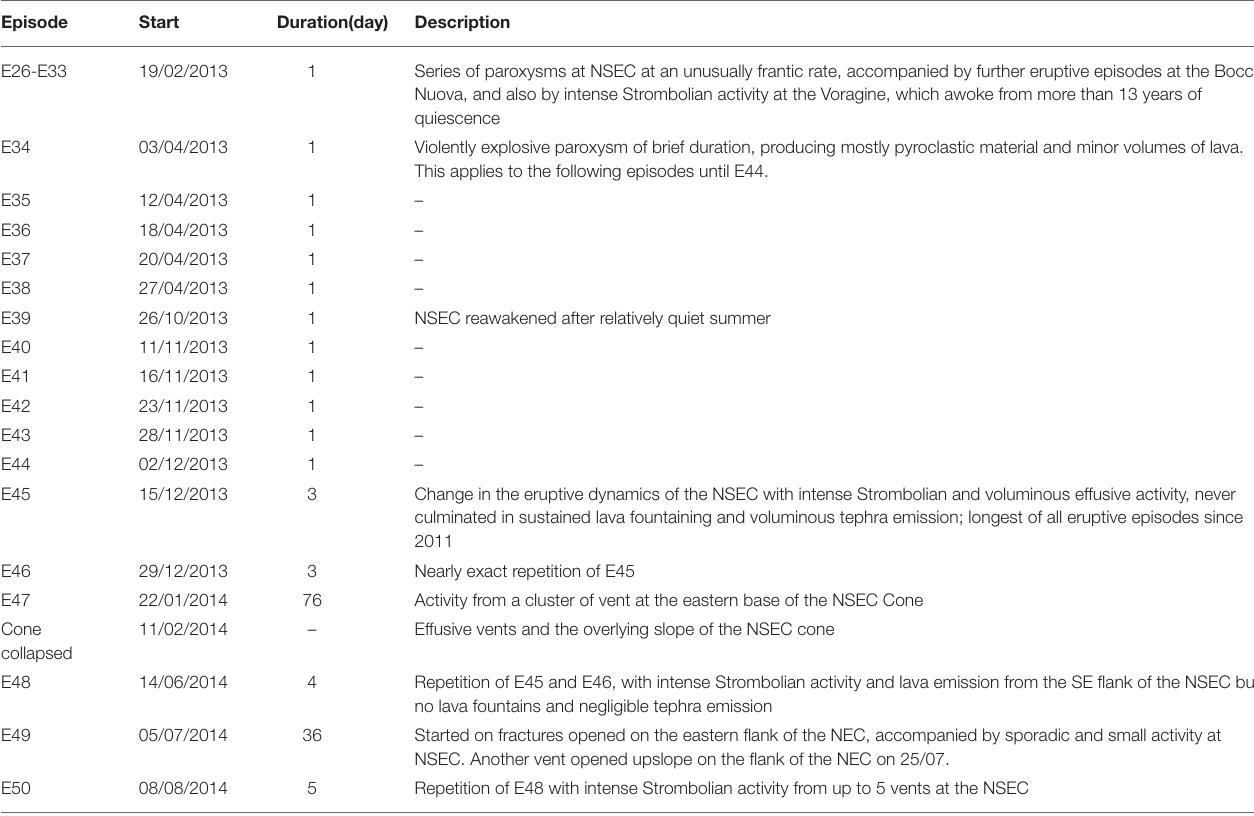
TABLE 1 | Chronology of the main eruptive activities at Mt. Etna volcano in 2013–2014, with the exception of the 28 December 2014 eruption.